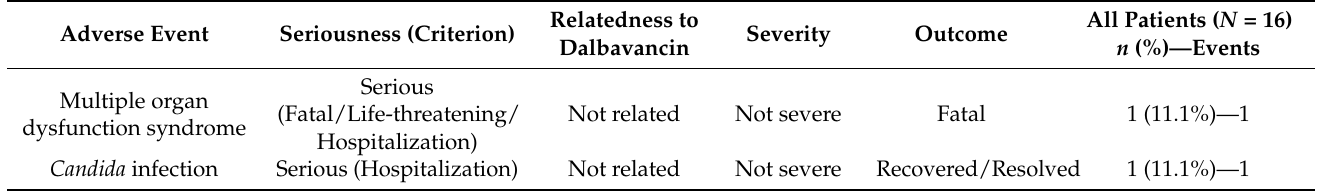
Table 3. Overview of adverse events (all